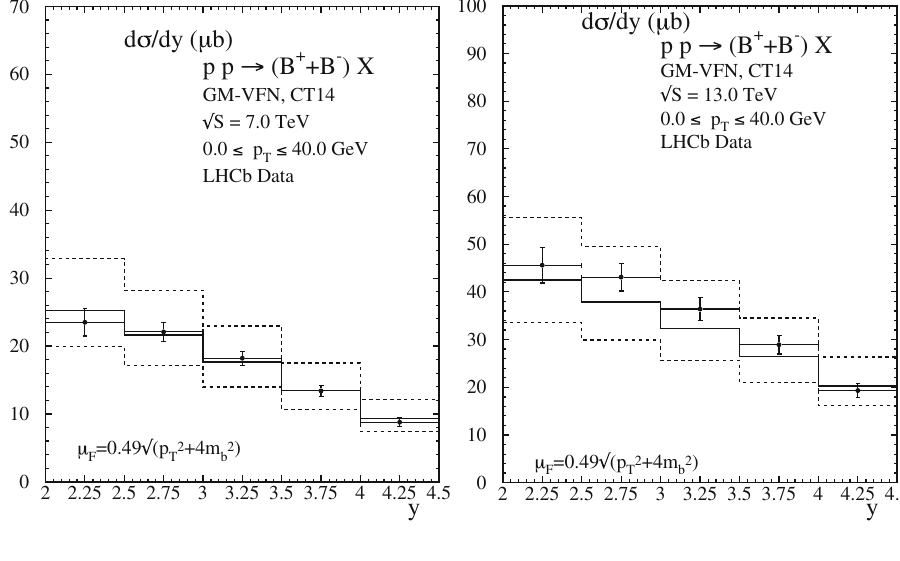
Fig. 6 y distribution of B ± √ S = 7 TeV (left) production at and 13 TeV (right), integrated over p T in the range 0 ≤ p T ≤ 40 GeV. The black points represent the measured values from the LHCb Collaboration. The full-line histogram is the prediction with the default choice of scales using the CT14 PDF set. The dashed histograms represent the theoretical